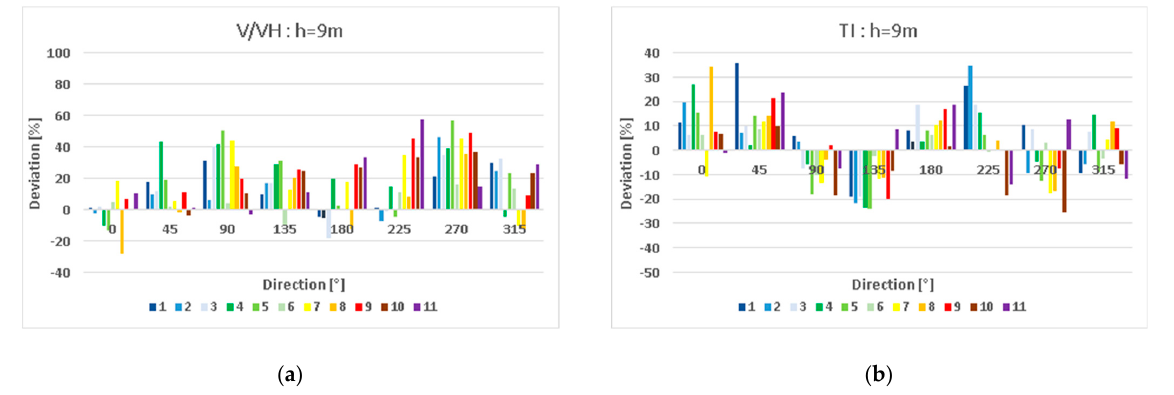
Figure 21. Mean absolute deviations of the wind ( a ) and turbulence intensity ( b ) per direction for the 11 probe validation points at height h = 9 m with Windsim.